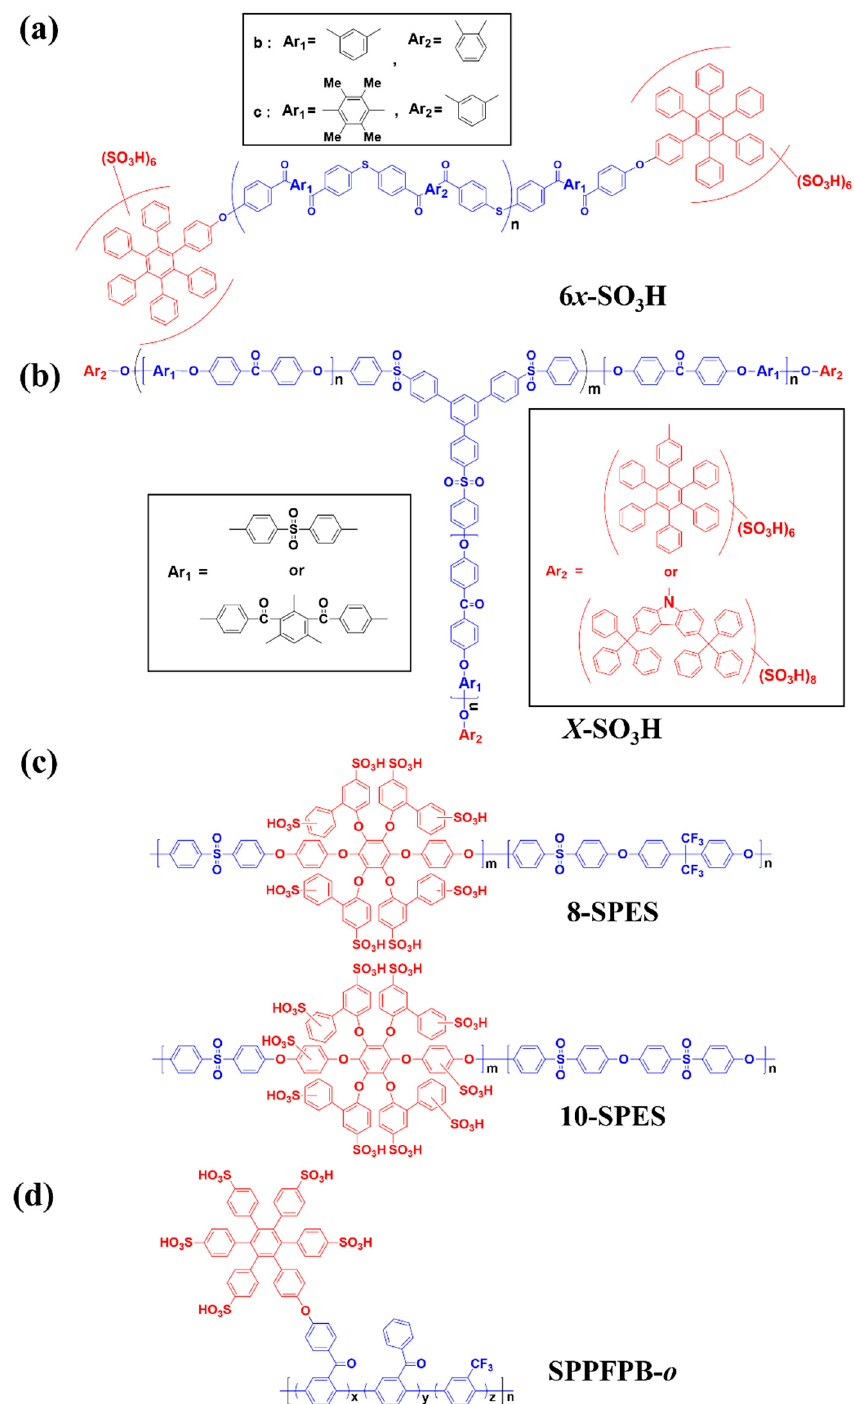
Figure 6. Representative chemical structures of densely sulfonated hydrocarbon-based copolymers. ( a ) 6 x -SO 3 H, ( b ) X -SO 3 H, ( c ) 8-SPES, 10-SPES and ( d ) SPPFPB- o [92–96,99].